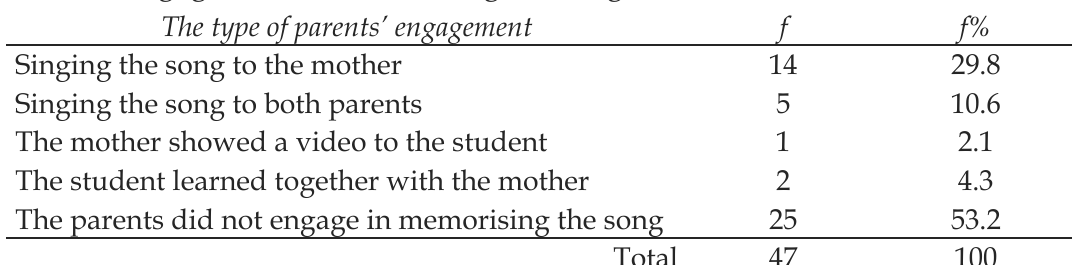
Table 2. The type of parents’